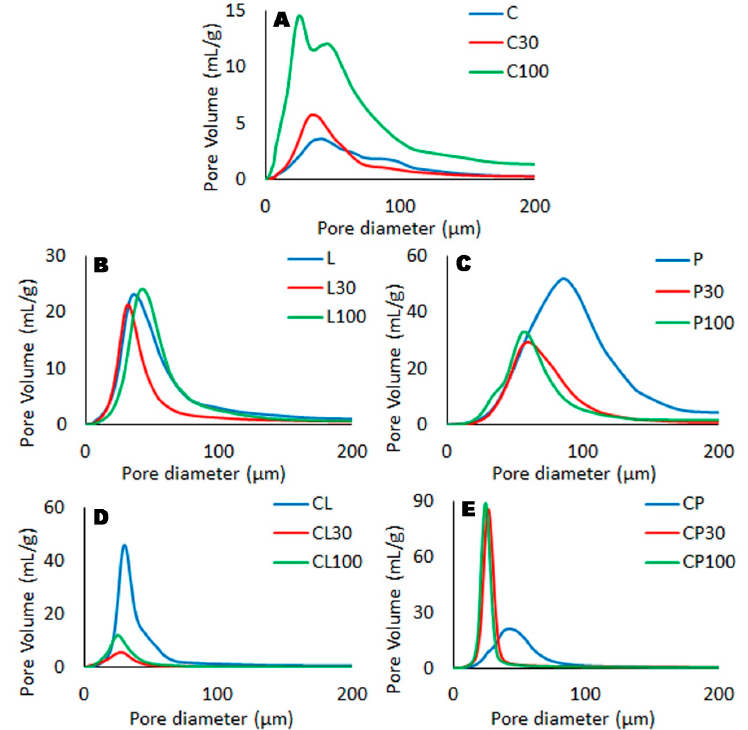
Figure 5. Results obtained from Hg porosimetry performed on the swelling witnesses of all the batches based on chitosan ( A ), locust bean gum ( B ), pectin ( C ), chitosan/locust bean gum ( D ) and chitosan/pectin ( E ).